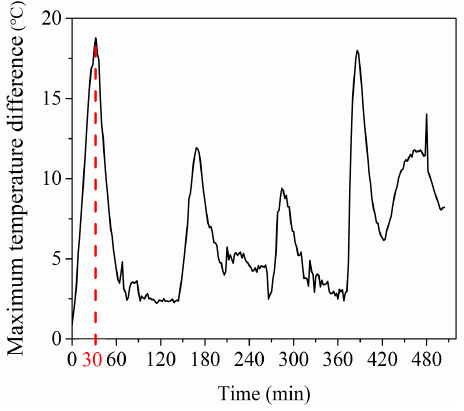
Figure 4. The temperature difference of 12 points.